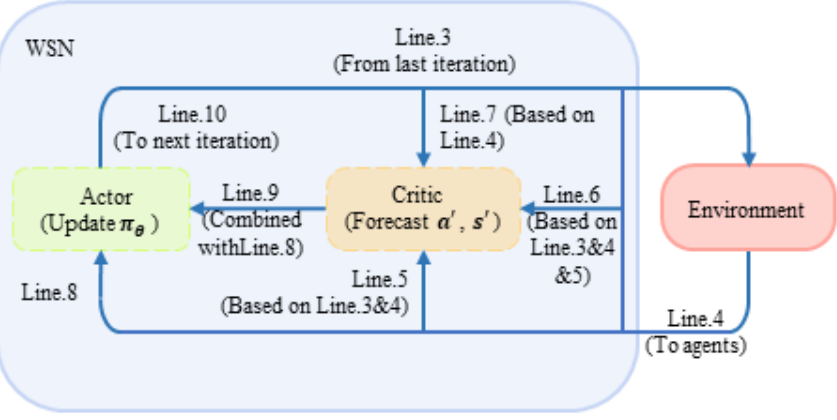
Figure 6. The diagram of DAJA’s flow based on actor–critic.